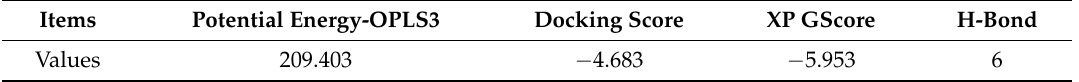
Table 2. Molecular docking values of methotrexate within caspase-1.